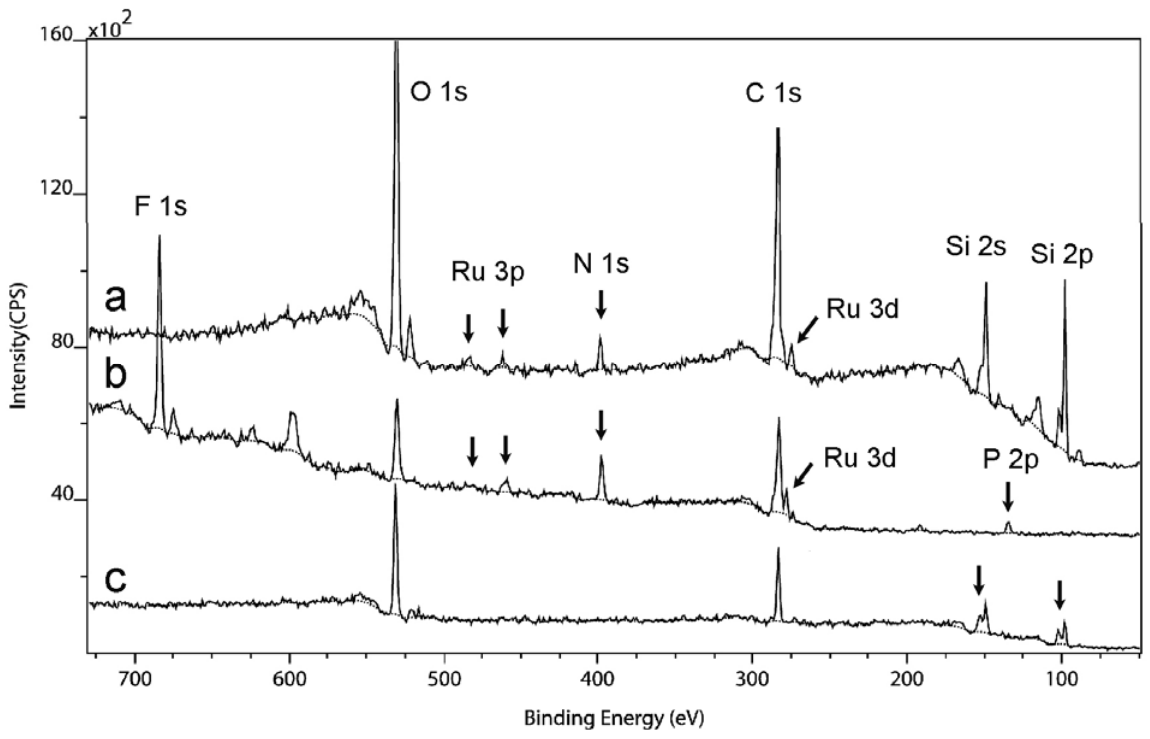
Figure 4. XPS spectra of a SiO (bottom curve) after soaking in an aqueous solution of Creutz-Taube ions. The XPS spectrum of a powder sample of Creutz-Taube ions, with (PF shown in the figure (middle